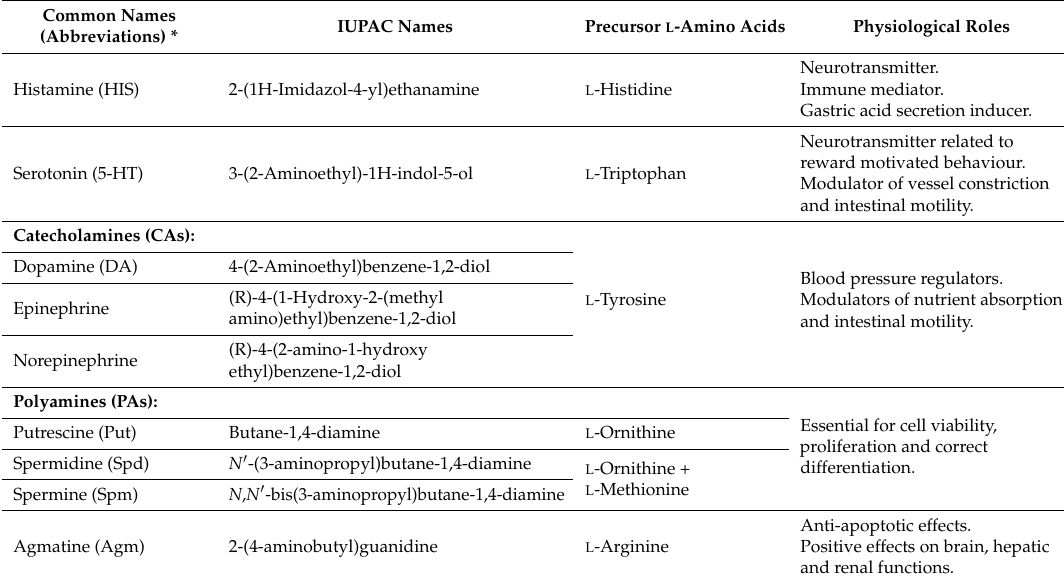
Table 1. Nomenclature, precursors and main functions of the basic and aromatic amines involved in the gastrointestinal